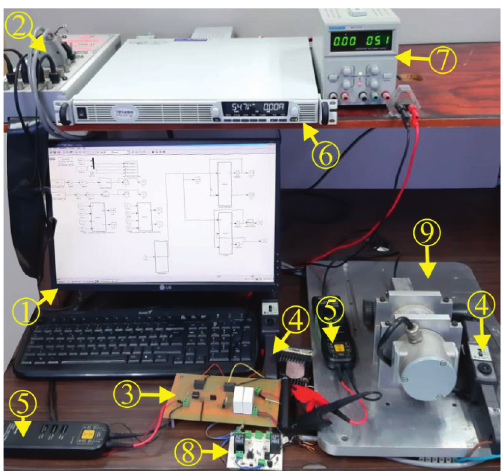
Figure 10: Photograph of the testbed associated with the DC/DC Buck converter-DC motor system. (1) PC, (2) DS1104 board from dSPACE, (3) DC/DC Buck converter, (4) Tektronix A622 current probes, (5) Tektronix P5200A voltage probes, (6) TDK-Lambda G100-17 programmable DC power supply, (7) power supply of the instrumentation stage, (8) electronic board to apply perturbations, and (9) DC motor.